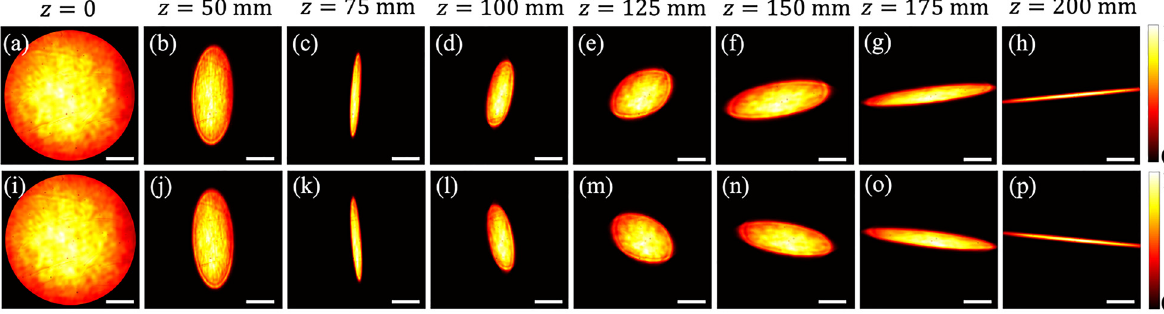
Figure 3: Experimental results of the normalized average intensity distributions of the generated TGSM source with μ 0 = 6 . 25mm − 2 (top) and μ = − 6 . 25mm − 2 (bottom), respectively, at different propagation distances. The scale bars in the fi gures are 0